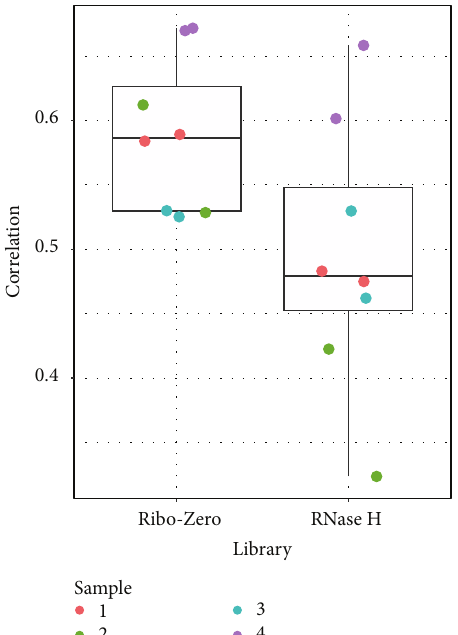
Figure 3: Spearman’s correlation coefficients between RNAseq data and NanoString data. The Ribo-Zero samples produced slightly higher correlation with NanoString data then RNase H samples. RNase H and NanoString is 0.49 (range: 0.32–0.66). The lowest correlation was produced by RNase H sample